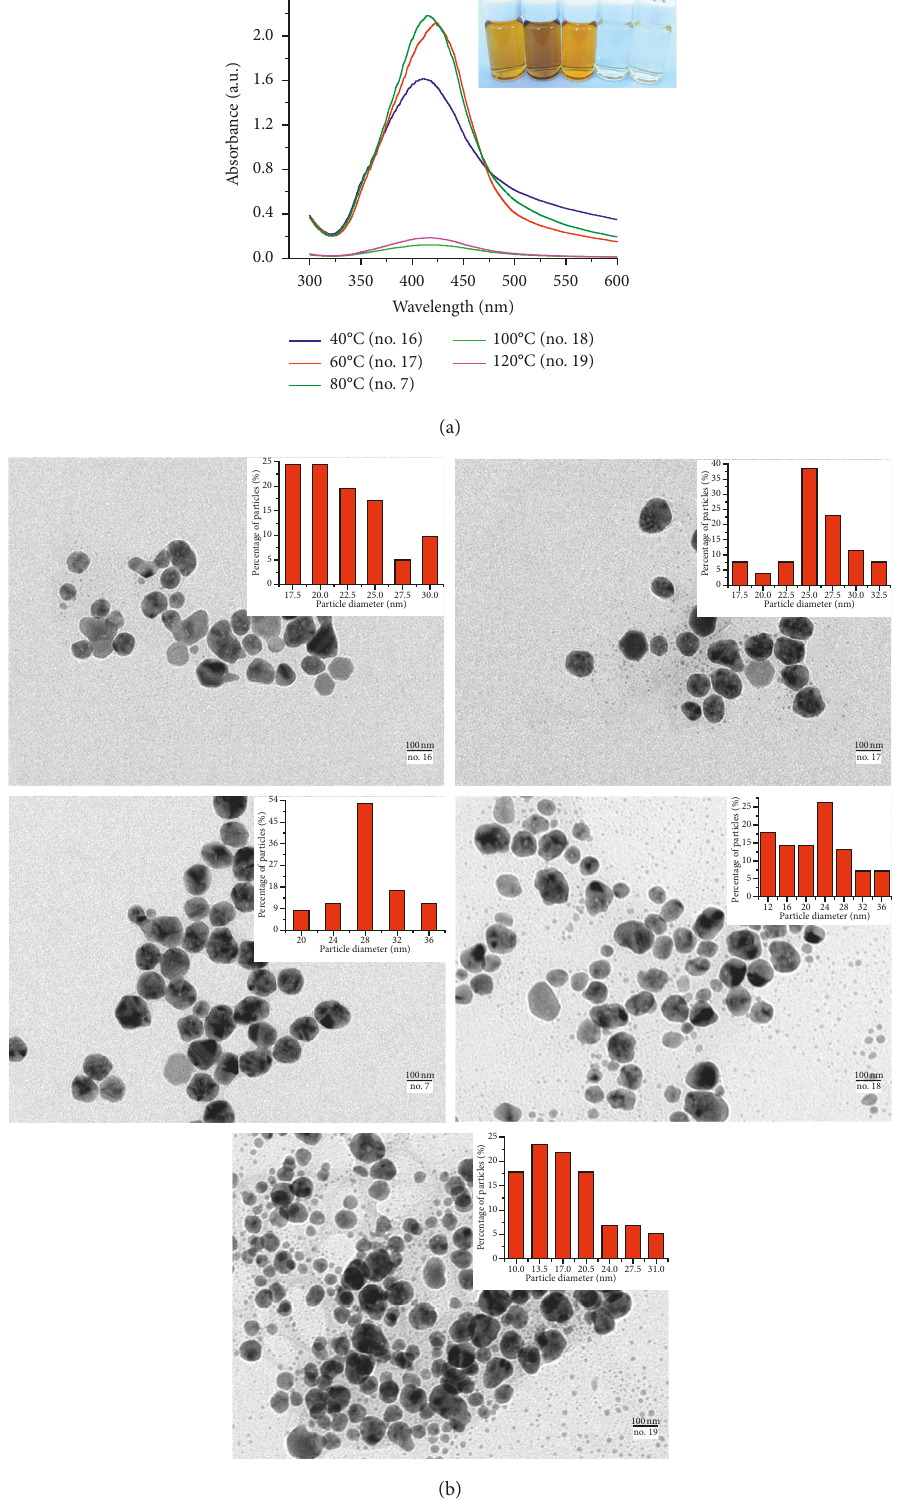
Figure 7: UV-Vis absorption spectra (a) and TEM images (b) of five groups of AgNPs synthesized under different